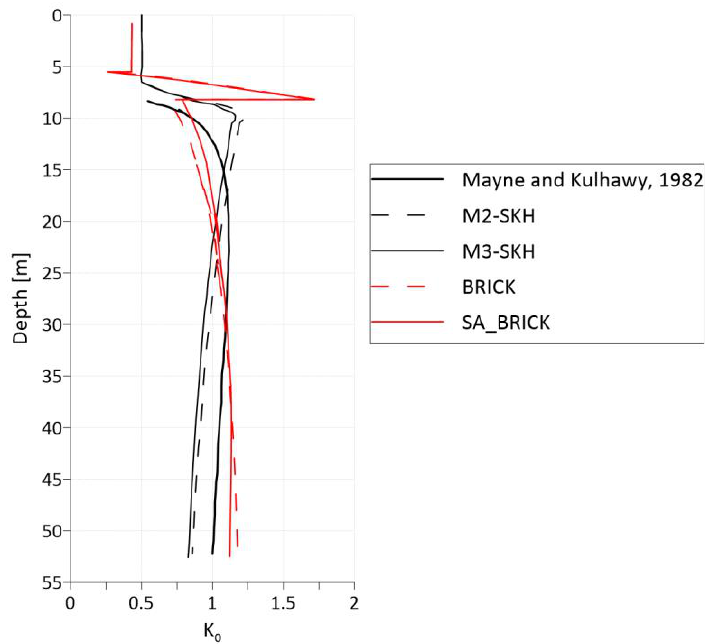
Figure 13. Initial K 0 profiles for different constitutive models used in the analyses with empirical correlation of Mayne and Kulhawy [57] as a reference.